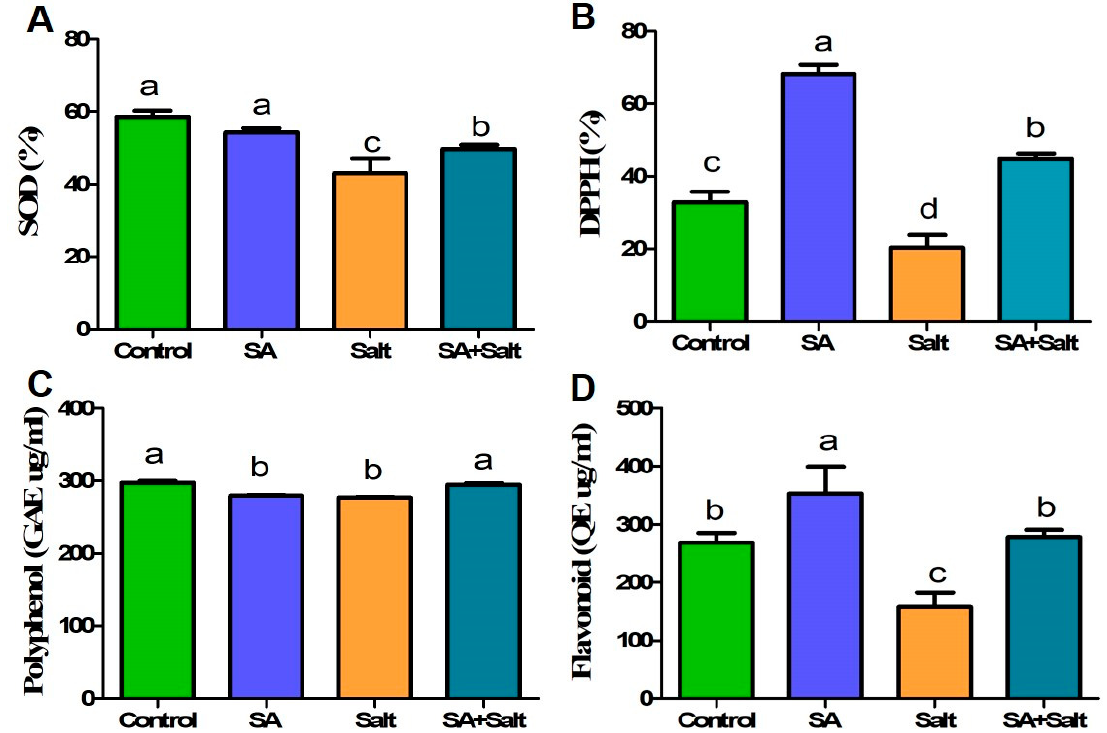
Figure 6. Determination of the enzymatic and non-enzymatic antioxidant activity of St. John’s wort under salt stress condition after salicylic acid treatment. Treatments: control, SA (0.25 mM salicylic acid), salt (150 mM NaCl), SA (0.25 mM salicylic acid) + salt (150 mM NaCl). Each value represents the mean ± SD ( n = 3). Different letters on each bar represent statistically significant differences as evaluated by DMRT and t ‐ test at p ≤ 0.05.